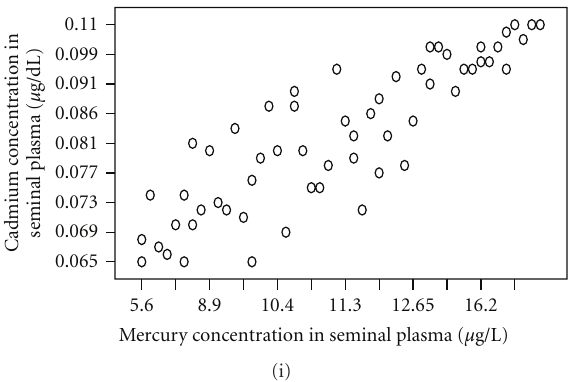
Figure 2: (a) Relation between lead and cadmium concentrations in whole blood. (b) Relation between lead and mercury concentrations in whole blood. (c) Relation between cadmium and mercury concentrations in whole blood. (d) Relation between lead and cadmium concentrations in blood plasma. (e) Relation between lead and mercury concentrations in blood plasma. (f) Relation between cadmium and mercury concentrations in blood plasma. (g) Relation between lead and cadmium concentrations in seminal plasma. (h) Relation between lead and mercury concentrations in seminal plasma. (i) Relation between cadmium and mercury concentrations seminal